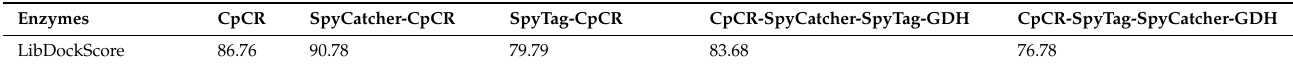
Figure 9. Comparison of activities of MESCs and free enzymes. (1) CpCR and GDH (free enzyme 1); (2) CpCR and SpyCatcher-GDH; (3) CpCR and SpyTag-GDH; (4) SpyCatcher-CpCR and GDH; (5) SpyCatcher-CpCR and SpyCatcher-GDH; (6) BESCs (CpCR-SpyCatcher-SpyTag-GDH); (7) SpyTag-CpCR and GDH; (8) BESCs (CpCR-SpyTag-SpyCatcher-GDH); (9) SpyTag-CpCR and SpyTag-GDH. Discovery Studio™ was used to simulate molecular docking. From the docking results of each enzyme with the OPBE molecule, CpCR, SpyCatcher-CpCR, SpyTag-CpCR, CpCR- SpyCatcher-SpyTag-GDH, and CpCR-SpyTag-SpyCatcher-GDH showed docking scores of 86.76, 90.78, 79.79, 83.68, and 76.78, respectively (Table 7). Table 7. Dock score.